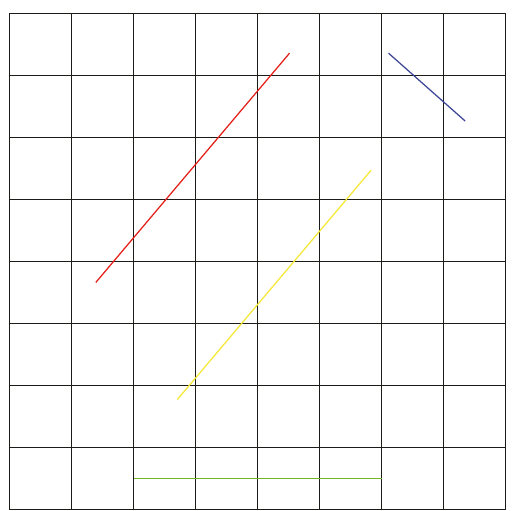
Figure 4: Illustration of 8 × 8 subgrid box with detected linear contrails. The contrails occurrence fraction defined in this example is (8 + 8 + 4 + 3)/64 =